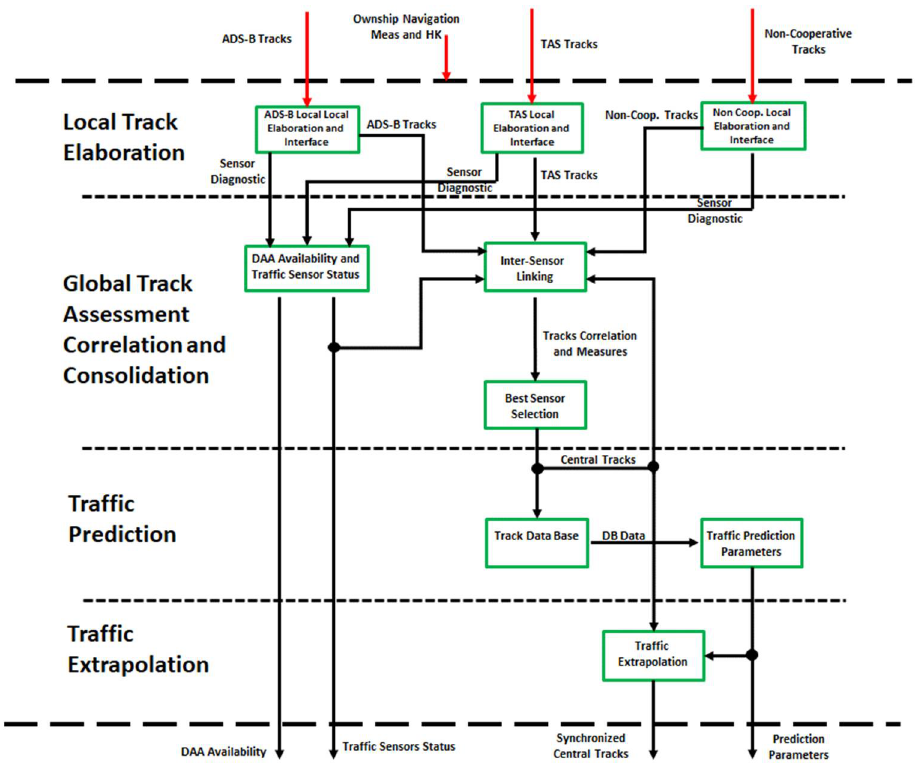
Figure 5. Surveillance Data Processing detailed architecture.